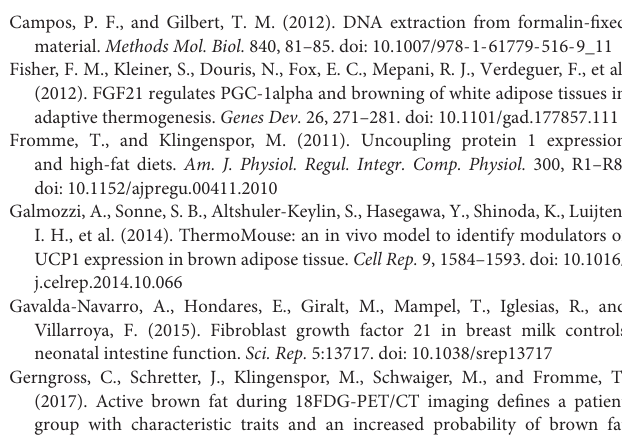
FIGURE S1 | Phase-contrast computed tomography images of the inguinal region of one example mouse 30 days of age in the coronal, transversal, and sagittal plane. Dotted lines indicate plane positions. Dashed lines envelope the anterior inguinal/lateral dorsolumbar adipose tissue depot. Irregular, light (high ED) structures of putative brite adipocyte nests traverse the dark (low ED) extent of white adipose